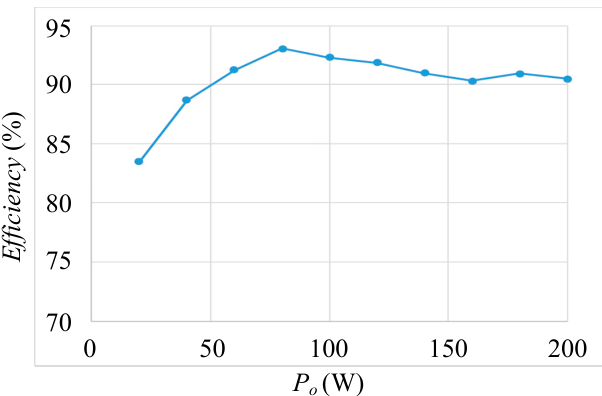
Figure 20. Measured converter e ffi ciency while only input port 2 powers the DHSIC.